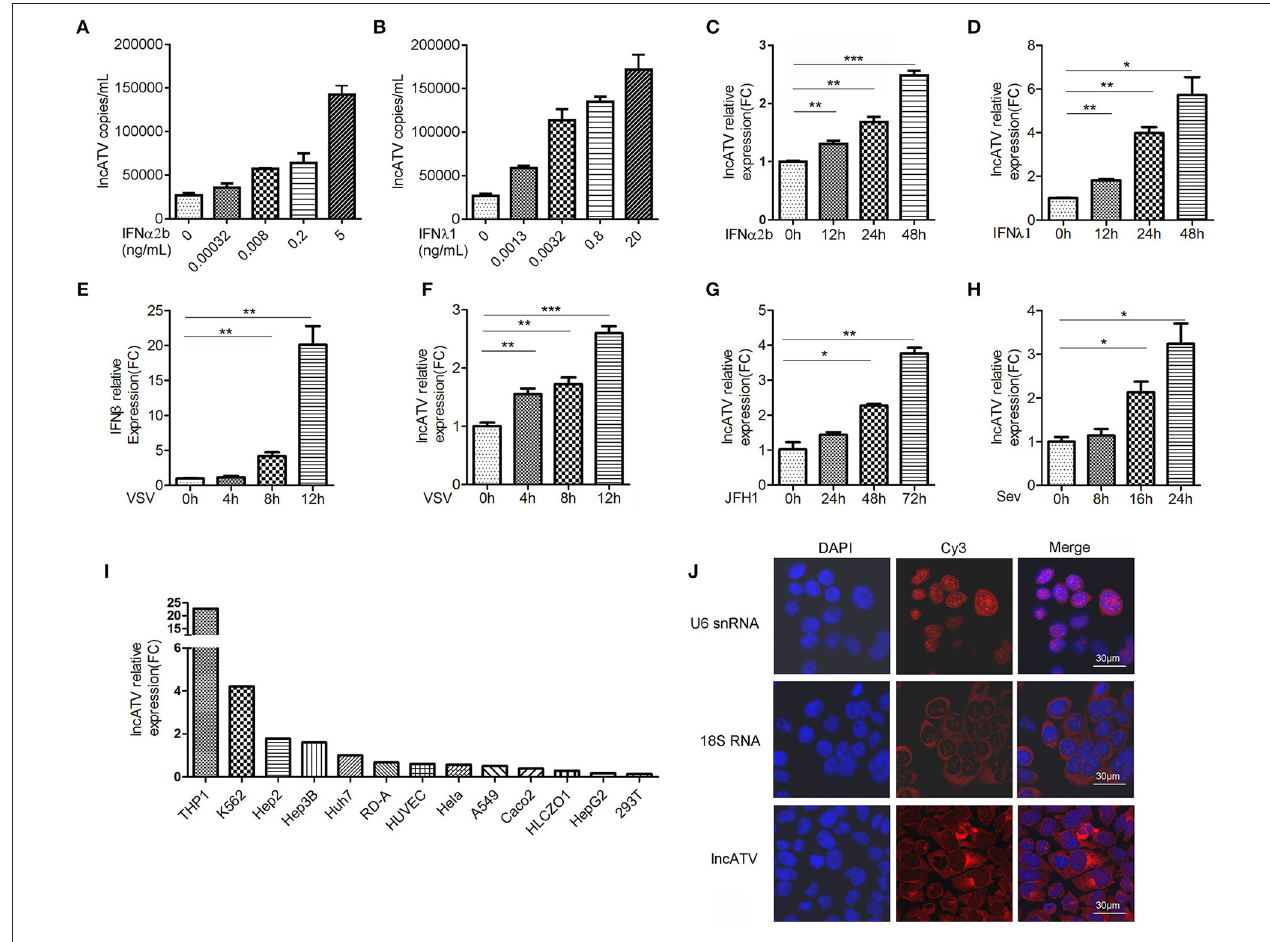
FIGURE 1 | LncATV is induced by IFNs and virus infections. (A,B) Endogenous LncATV expression levels were analyzed by absolute qRT-PCR in IFN α 2b (A) or IFN λ 1 (B) stimulated Huh7 cells at different IFN dosages. The treatment duration was set to 48h. (C,D) Endogenous LncATV expression levels were analyzed by relative qRT-PCR in IFN α 2b (C) or IFN λ 1 (D) stimulated Huh7 cells at different treatment timepoints. The treatment concentration is 1ng/mL for IFN α 2b and 25ng/mL for IFN λ 1. (E) The levels of IFN β mRNA were determined by qRT-PCR in Huh7 cells after VSV infection. (F–H) The expression levels of LncATV were analyzed by qRT-PCR in VSV (F) , JFH-1 HCVcc (G) , or SeV (H) infected Huh7 cells at various infection time points. (I) Quantitative RT-PCR determination of the endogenous lncATV abundance in multiple tissue type derived cell lines. The relative level of lncATV in Huh7 cells was set as 1. (J) RNA FISH detecting the subcellular localization of endogenous lncATV molecules in Huh7 cells. U6 snRNA or 18S RNA specific probes were used as control to indicate nucleus or cytoplasm localization, respectively. Red signals show Cy3-labeled RNAs, and DNA (blue) was stained with DAPI. A representative image is shown. Scale bars, 30 µ m. Data are representative of three independent experiments and plotted as the mean ± s.d. * P < 0.05, ** P < 0.01, *** P < 0.001 vs. the control